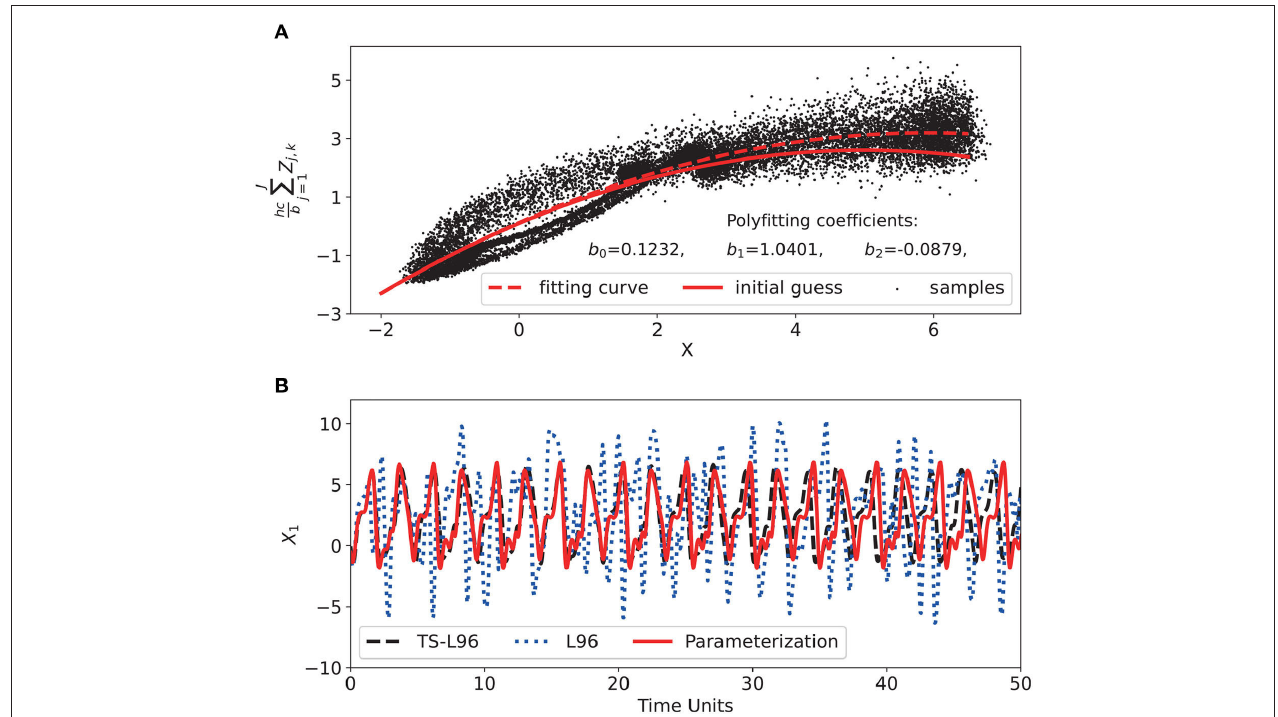
FIGURE 1 | (A) Scatter plot of the effect of unresolved Z variables as a function of the resolved X variables, together with the regression functions constituting the parameterization. (B) Control run of the parameterized Lorenz-96 model (red solid line) and the truncated Lorenz-96 model (blue dotted line) for variable x 1 .